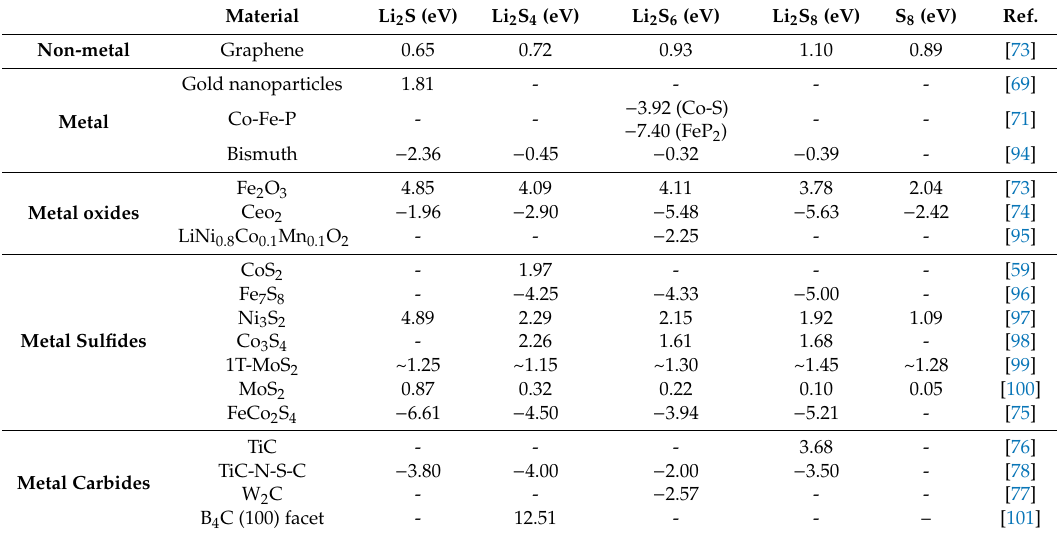
Table 2. Binding energies (eV) between various electrocatalysts and LiPS, obtained from first principle DFT